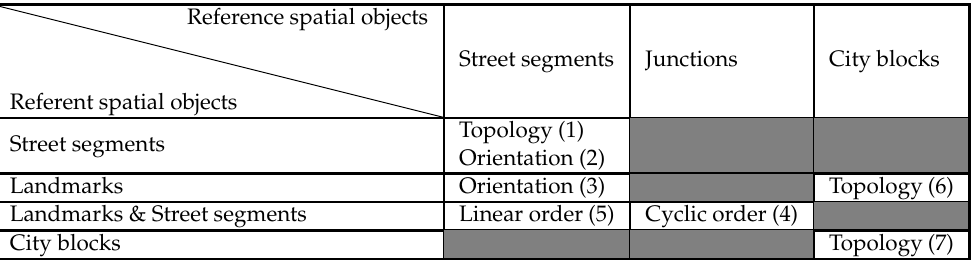
Table 2: The new seven sketch aspects numbering from (1) to